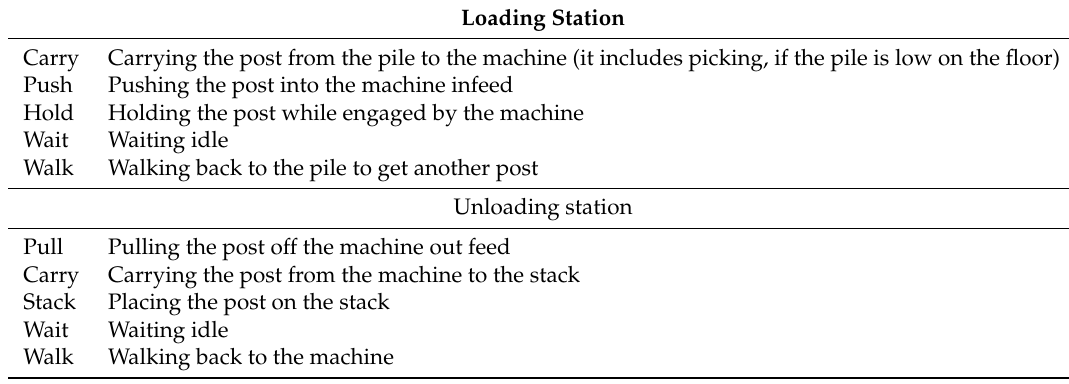
Table 2. Description of main